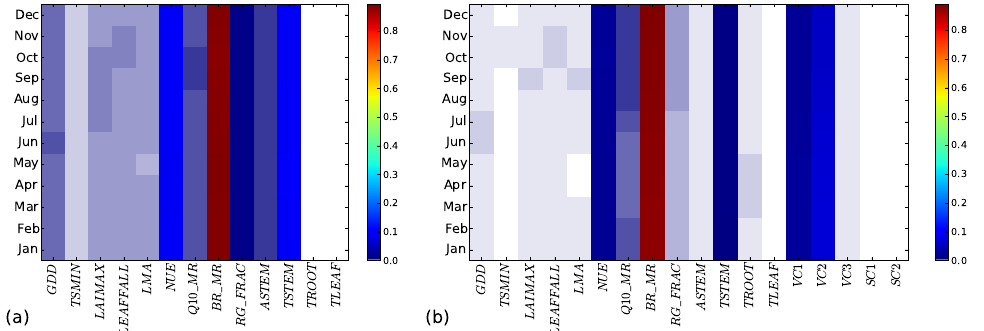
Figure 5. Matrices with total effect Sobol indices, S T to the one in Fig. 3.